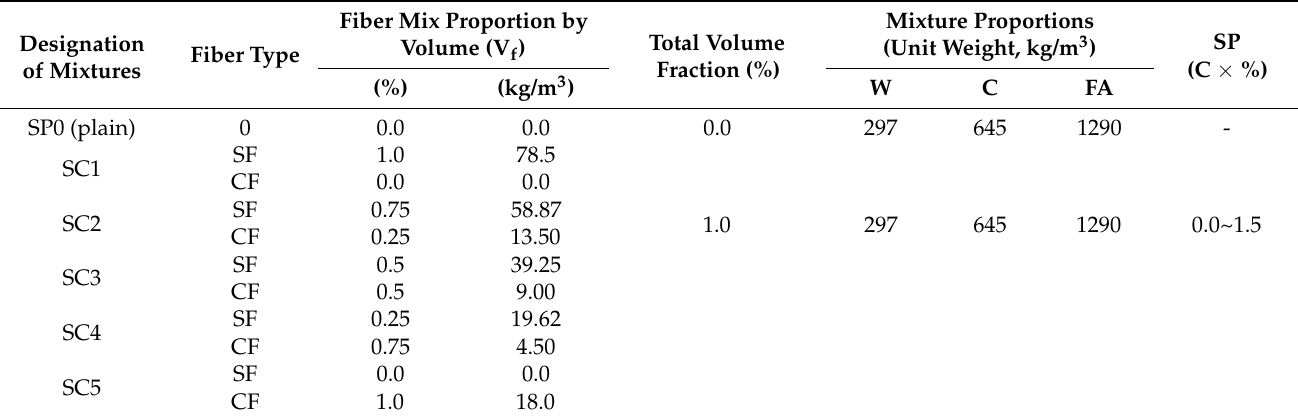
Table 3. Mixture designation and used materials proportions.